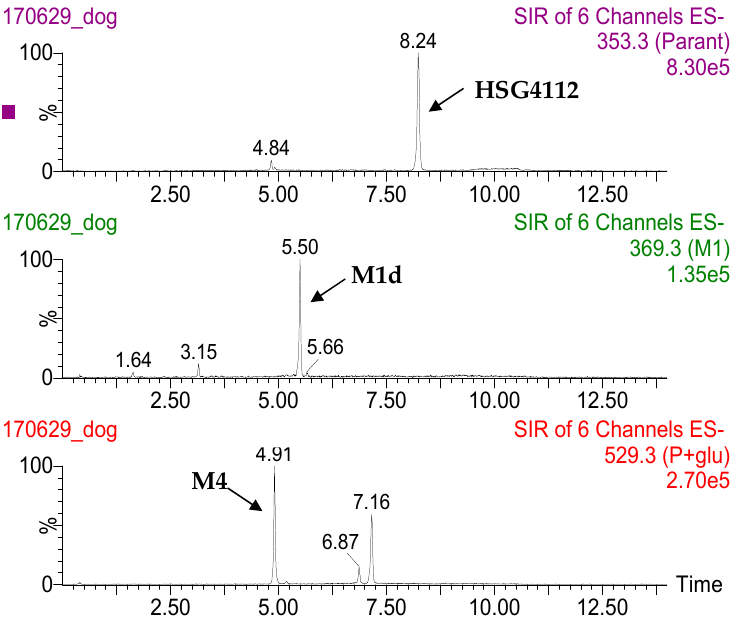
Figure 9. Representative extracted ion chromatograms of HSG4112 and its metabolites in dog plasma.